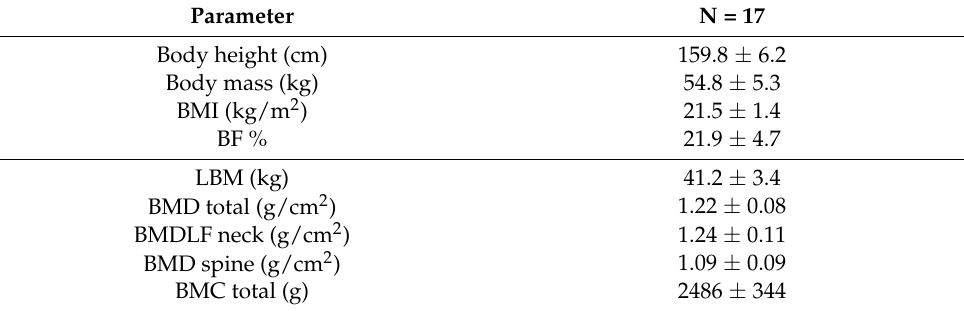
Table 2. Anthropometrics and body composition status (mean ±